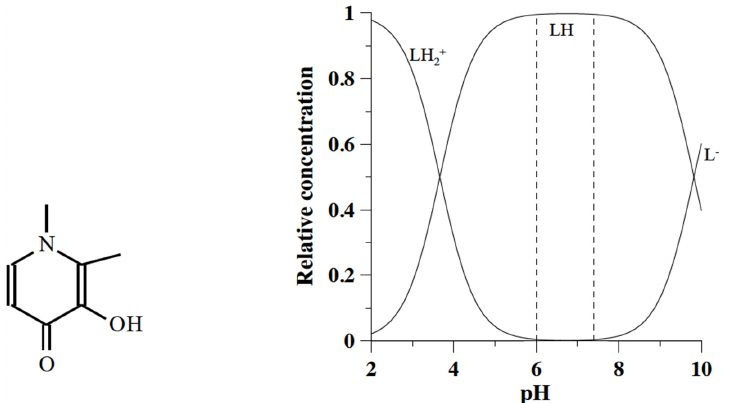
Fig 2. Molecular formula of deferiprone and speciation plots of its variously protonated